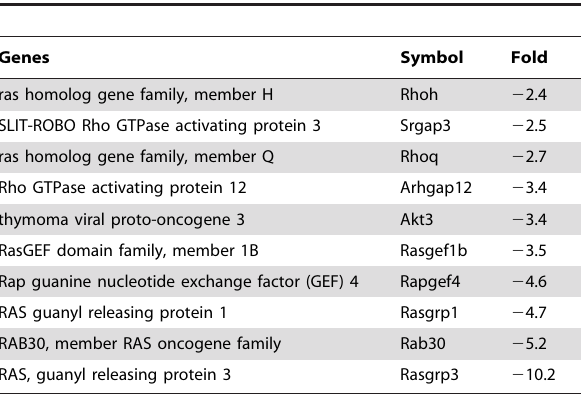
Table 6. Up-regulation of cyclin proteins in lal 2 / 2 bone marrow